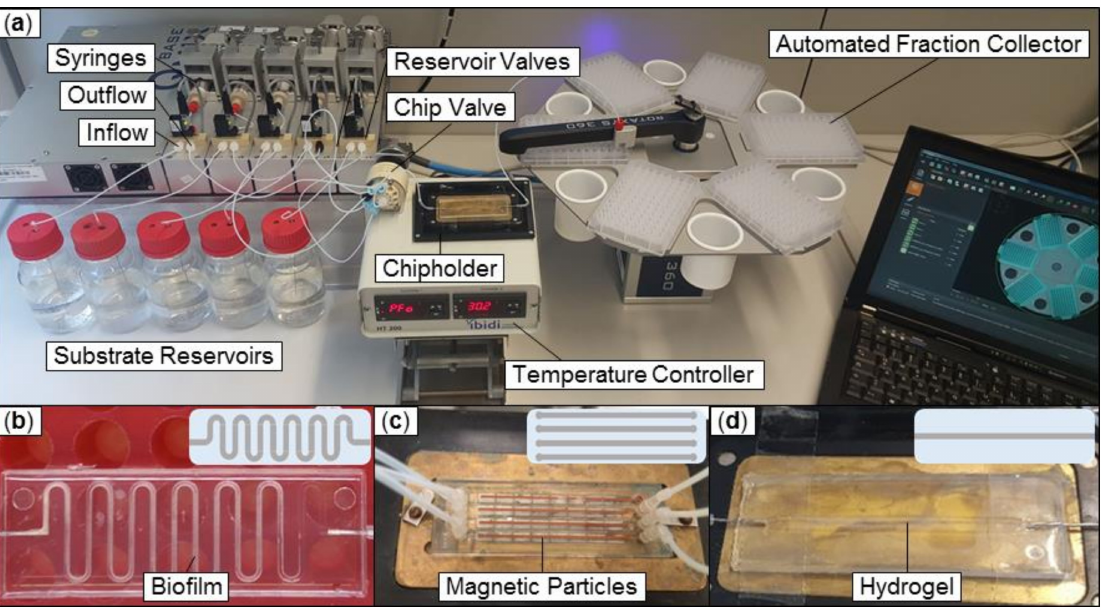
Figure 1. Setup for continuous flow biocatalysis using microfluidic chip reactors. ( a ) Overview of the microfluidic system with photo and scheme of ( b ) polydimethylsiloxane (PDMS) chip with meandering flow path containing a productive Escherichia coli biofilm. ( c ) polymethylmethacrylate (PMMA)